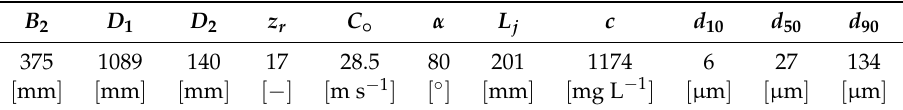
Table 1. Test Case Geometric